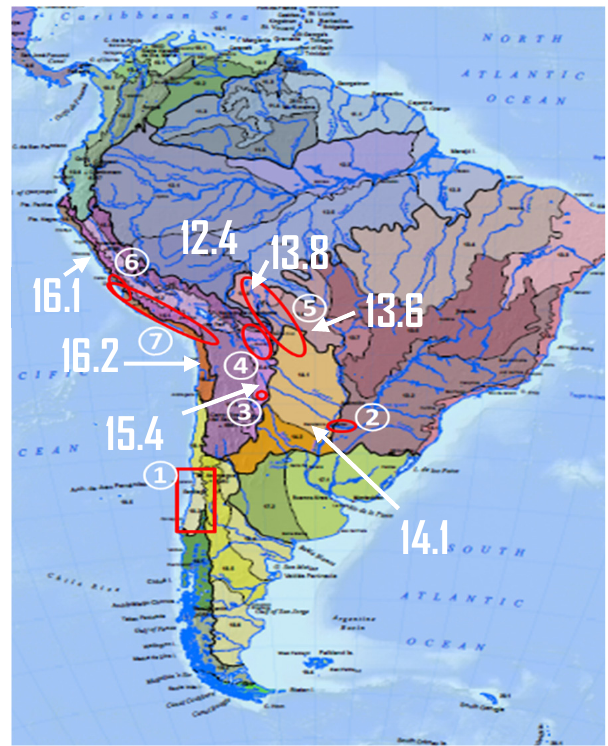
Figure 5. Biogeographical map of South America sensu Rivas-Martínez et al. (2011b). The rectangle indicates the Central Chilean province and the ellipses denote the tropical areas that contain the willow communities shown in Table 3. Biogeographical provinces concerned (numeric codes are the same as in the map from Rivas-Martínez et al. ( op.cit. ): 12.4: Southwest Amazonian; 13.6: West Cerrado; 13.8: Benian; 14.1: North Chacoan; 15.4: Bolivian-Tucumanan; 16.2: Hyperdesertic North Peruvian; 16.2: Hyperdesertic Tropical